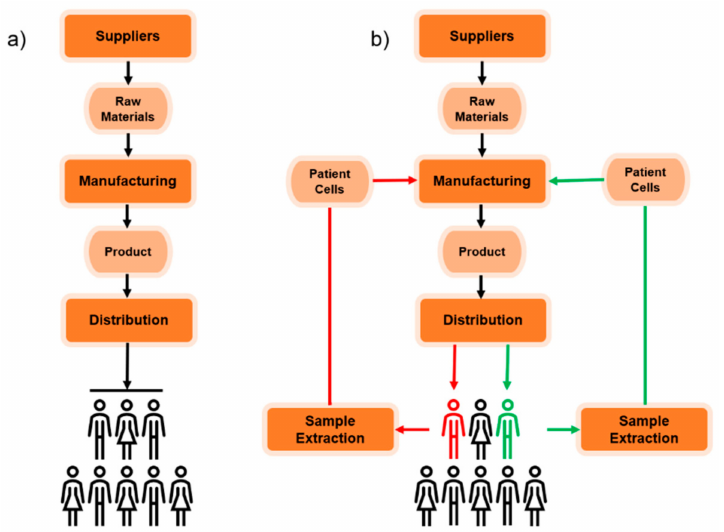
Figure 2. Pharmaceutical supply chain for ( a ) batch-produced drugs and ( b ) patient-specific thera-